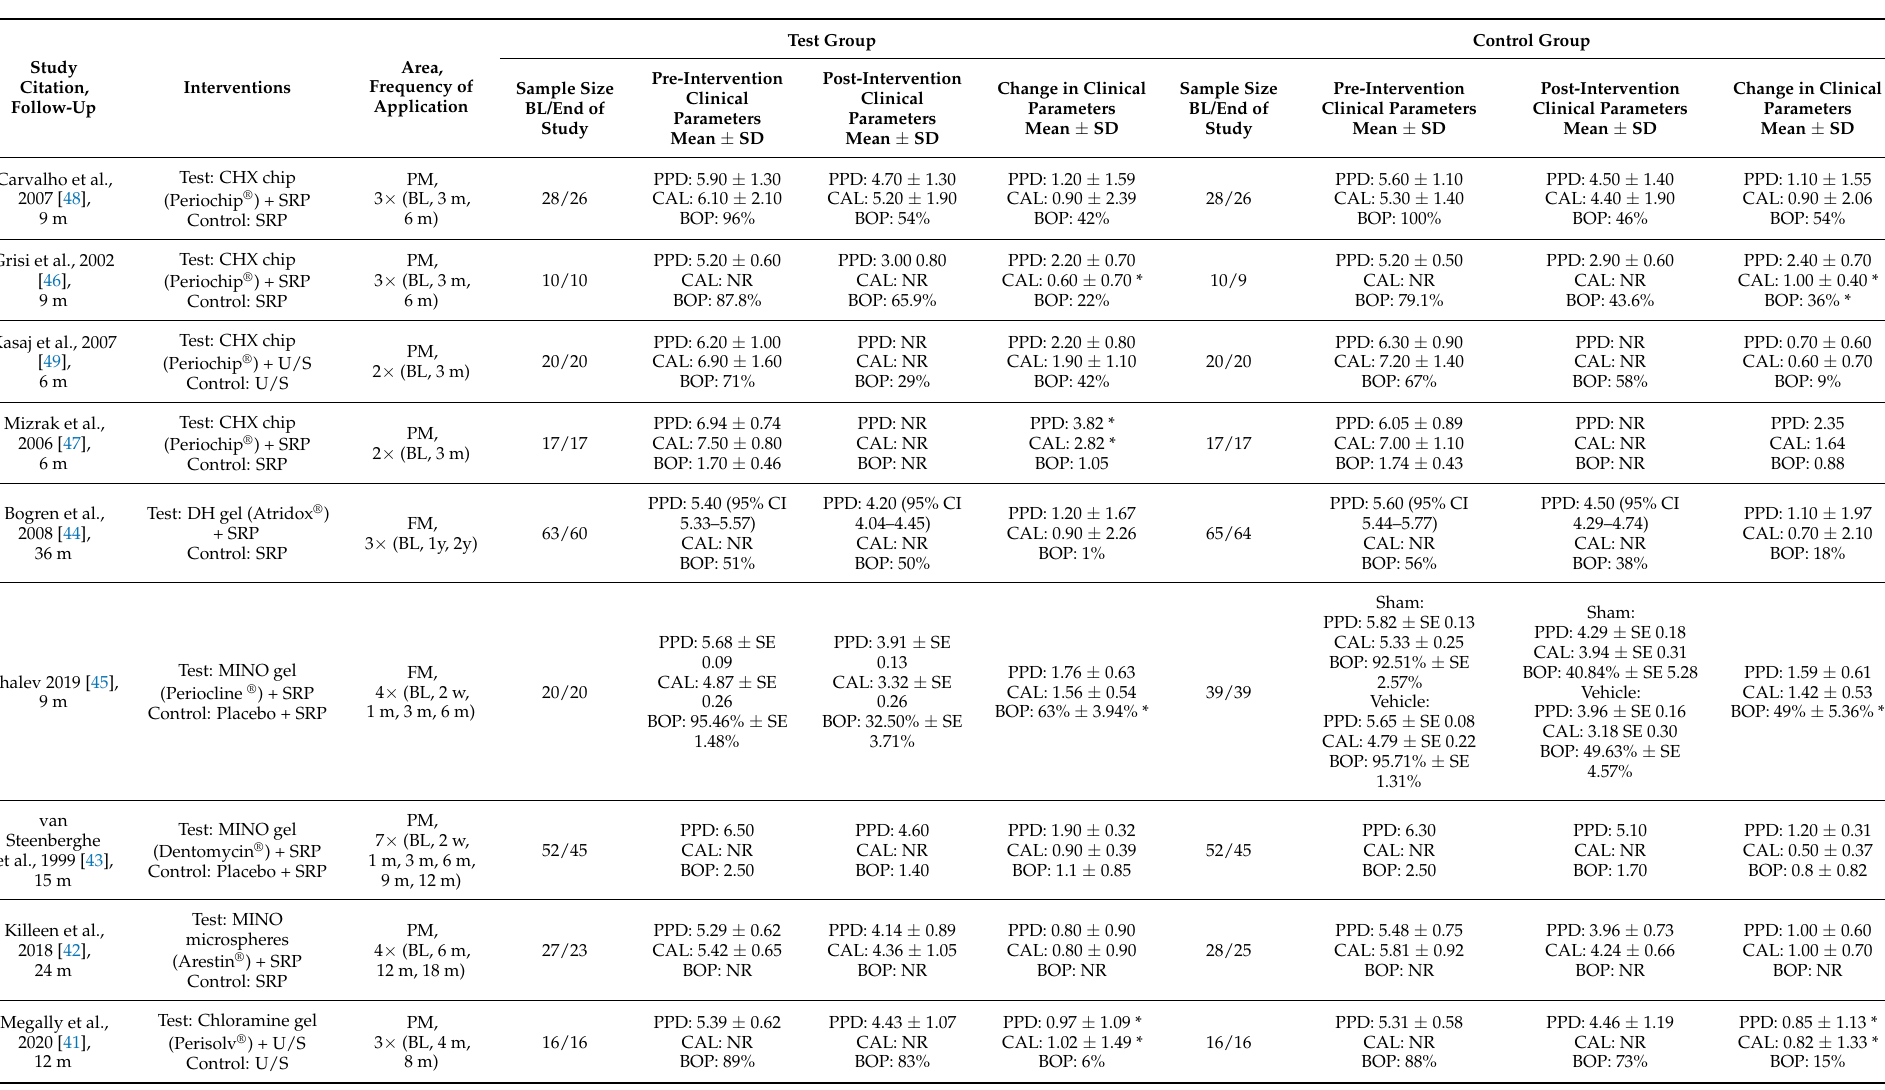
Table 2. Intervention characteristics and outcomes data of the included studies based on adjuncts.